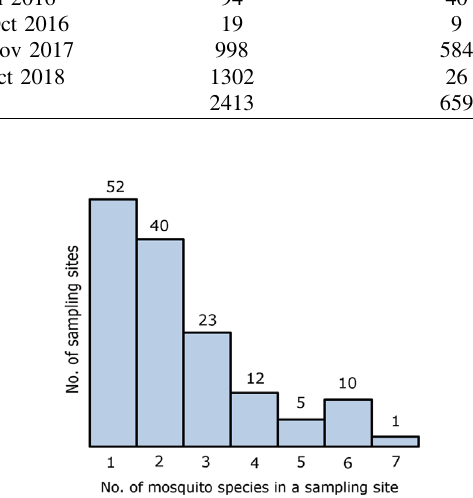
Figure 2. Number of sampling units that were found to be positive for mosquitoes (total = 143), according to the number of mosquito species observed in each sampling, June 20 to July 10, 2016. Anopheles maculipennis s.l . is considered a “ species ” when no precise species from the complex is